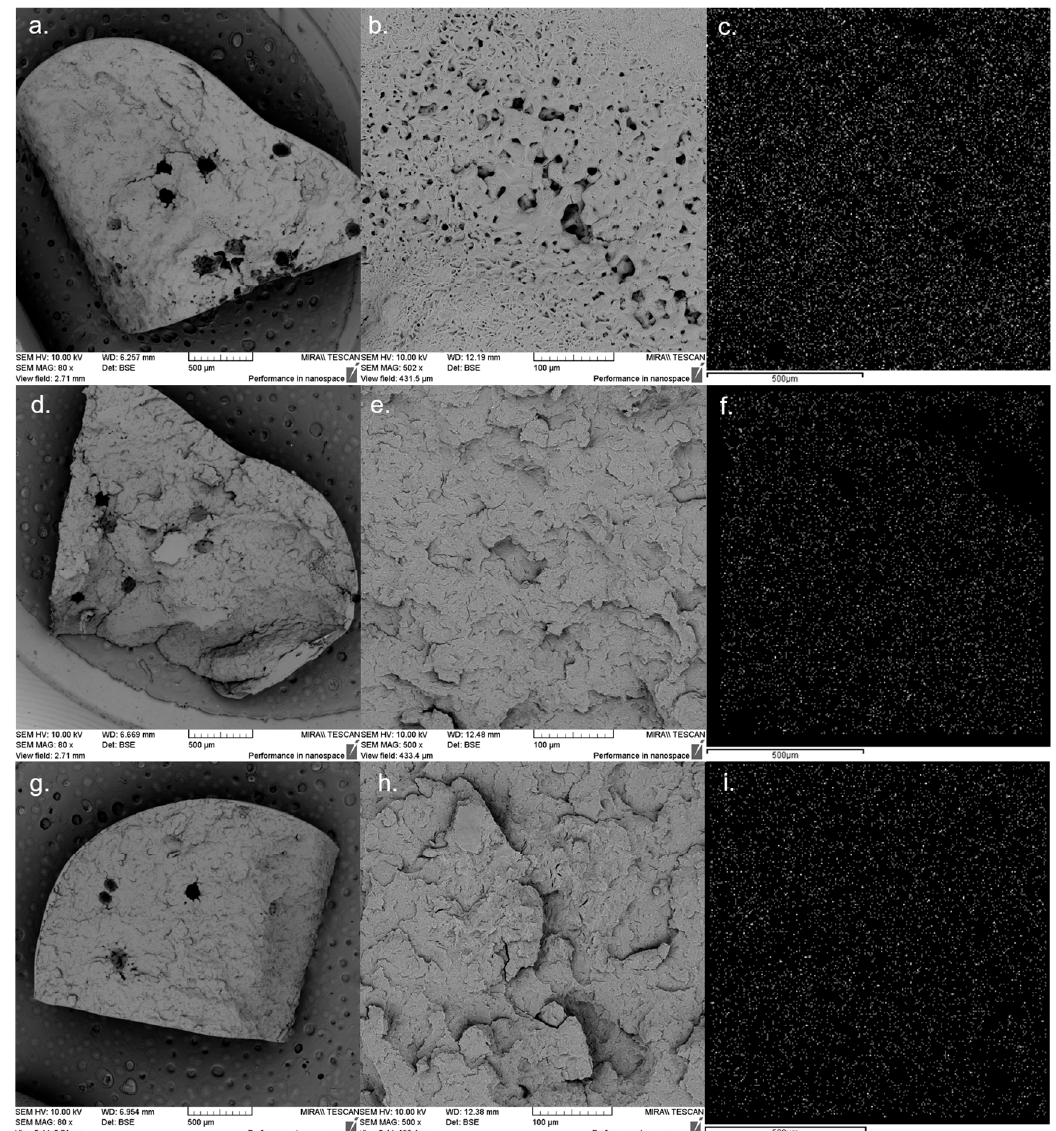
Figure 6 . SEM images of formulation 1 ( a , b ), formulation 2 ( d , e ) and formulation 3 ( g , h ) showing the topography and morphology of extrudates followed by EDX analysis of formulation 1 ( c ), formulation 2 ( f ) and formulation 3 ( i ) showing the homogeneous distribution of the element sulfur from Fen within PEO/PCL blends.